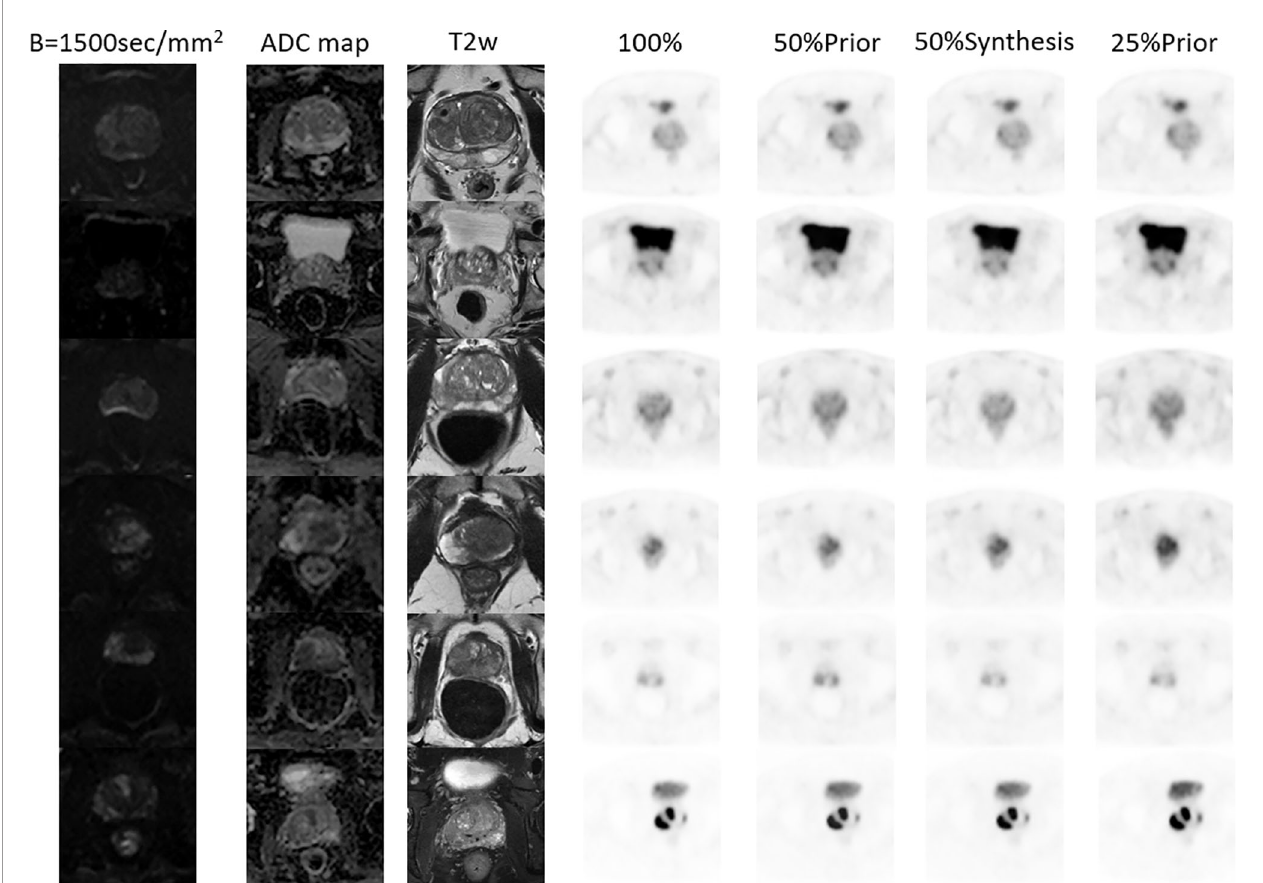
FIGURE 5 | MR and PET images of 6 patients with prostate or pelvic lesions from the test set. The MR sequences included DW-, ADC- and T2-weighted images. The PET images consist of the original FDPET images, FDPET images synthesized from 50%-dose images with MR priors, FDPET images synthesized from 50%- dose images without MR priors, and FDPET images synthesized from 25%-dose images with MR priors.